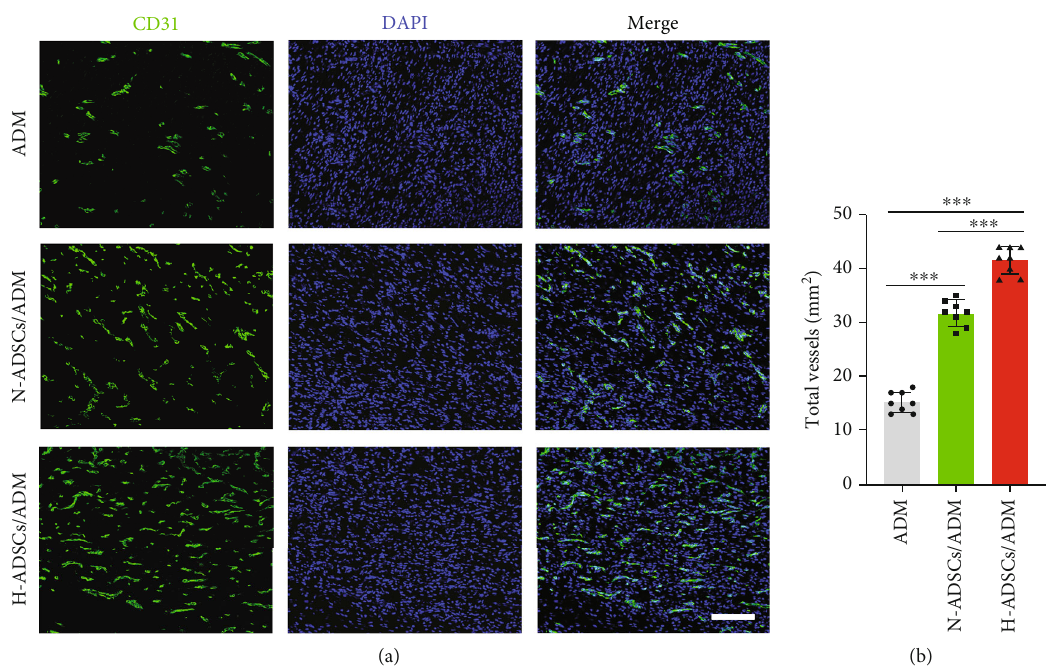
Figure 9: H-ADSCs/ADM membrane stimulating angiogenesis in diabetic wounds. (a) Immuno fl uorescence analysis of sections for CD31 showed the formation of microvessels in the ADM, N-ADSCs/ADM, and H-ADSCs/ADM groups. Bar = 100 μ m. (b) CD31 area quanti fi cation showed the quantitative analysis of the number of total blood vessels in wounds at day 7 postoperation, n = 8 per group. All data are shown as means ± standard deviation ( ∗ P < 0 : 05 , ∗∗ P < 0 : 01 , and ∗∗∗ P < 0 : 001